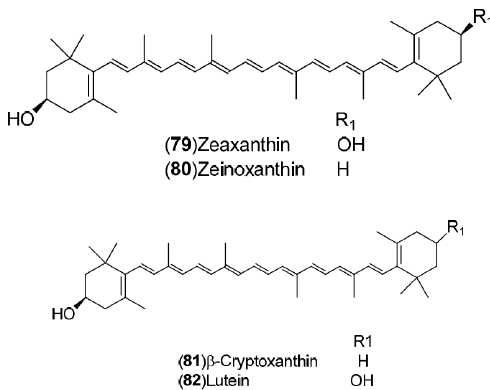
Figure 8. Chemical structures of carotenoids.